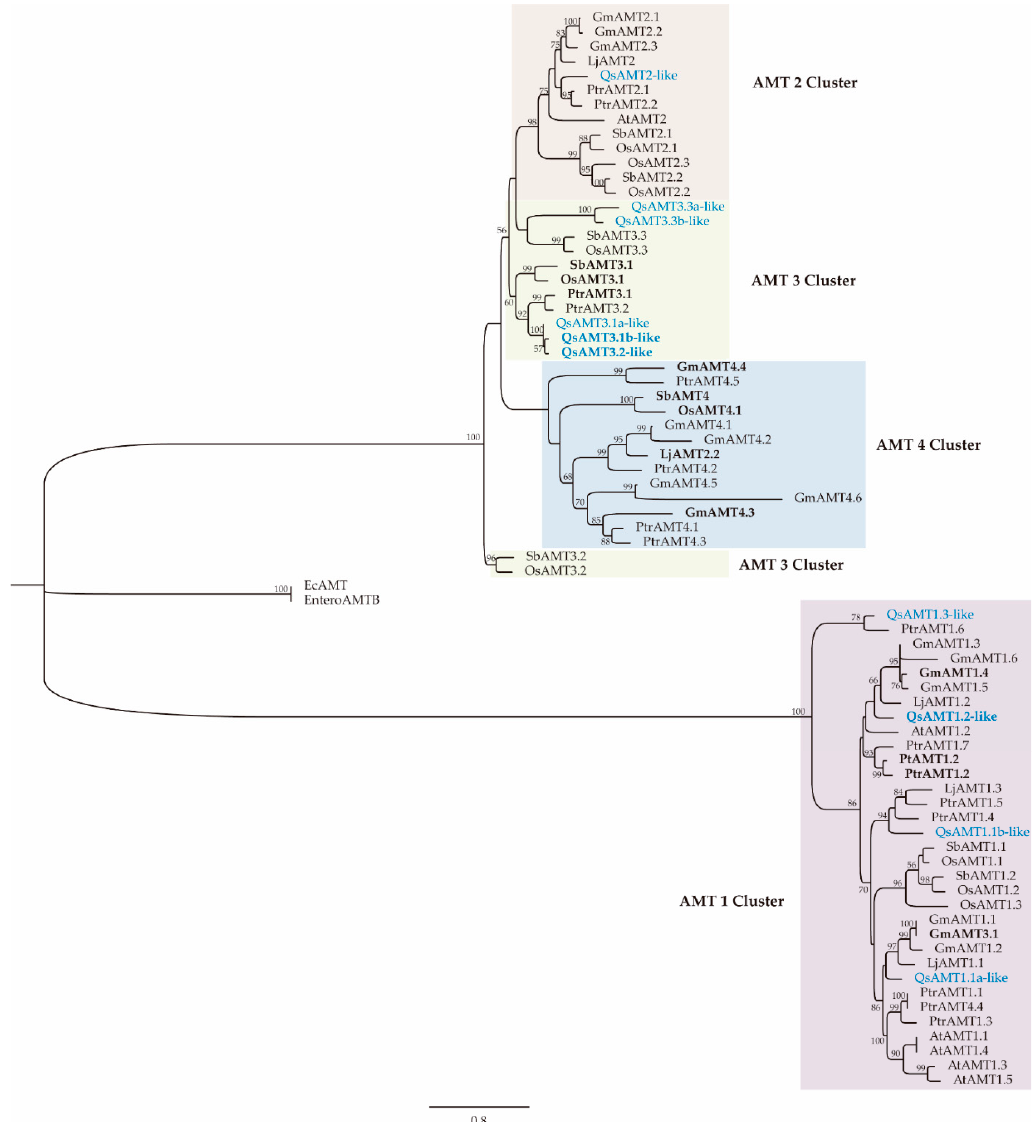
Figure 2. Maximum-likelihood tree of the ammonium transporter (AMT) protein family. Bootstrap was performed using 1000 replicated tests. Species codes: Ec, Escherichia coli ; Sb, Sorghum bicolor ; At, Arabidopsis thaliana ; Gm, Glycine max ; Lj, Lotus japonicus ; Os, Oryza sativa ; Ptr, Populus trichocarpa ; Qs, are in blue